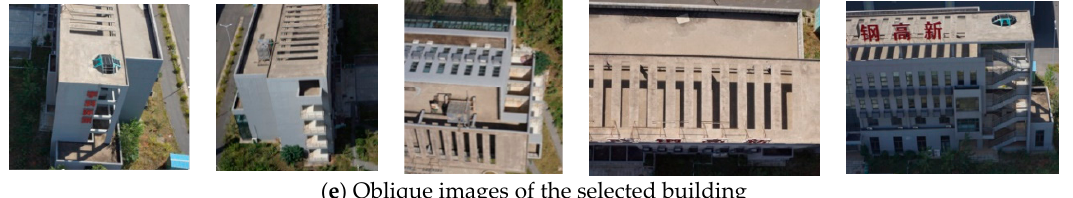
Figure 9. The data acquisition equipment and multi-source data of the experiment area.